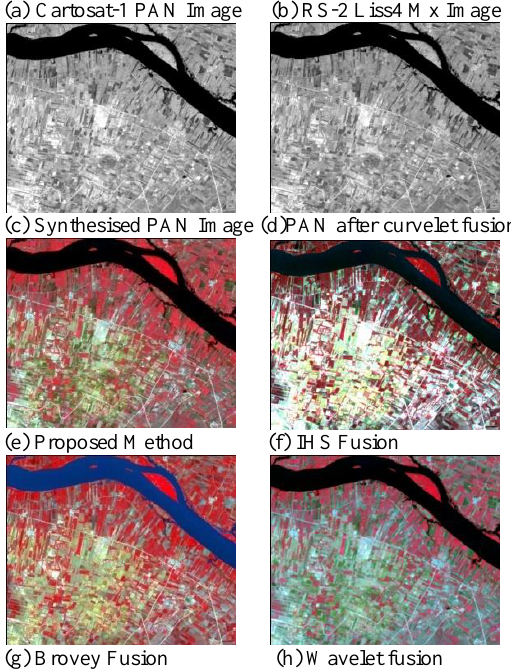
Figure 7: Zoomed around Kudala sangama,Karnataka scene